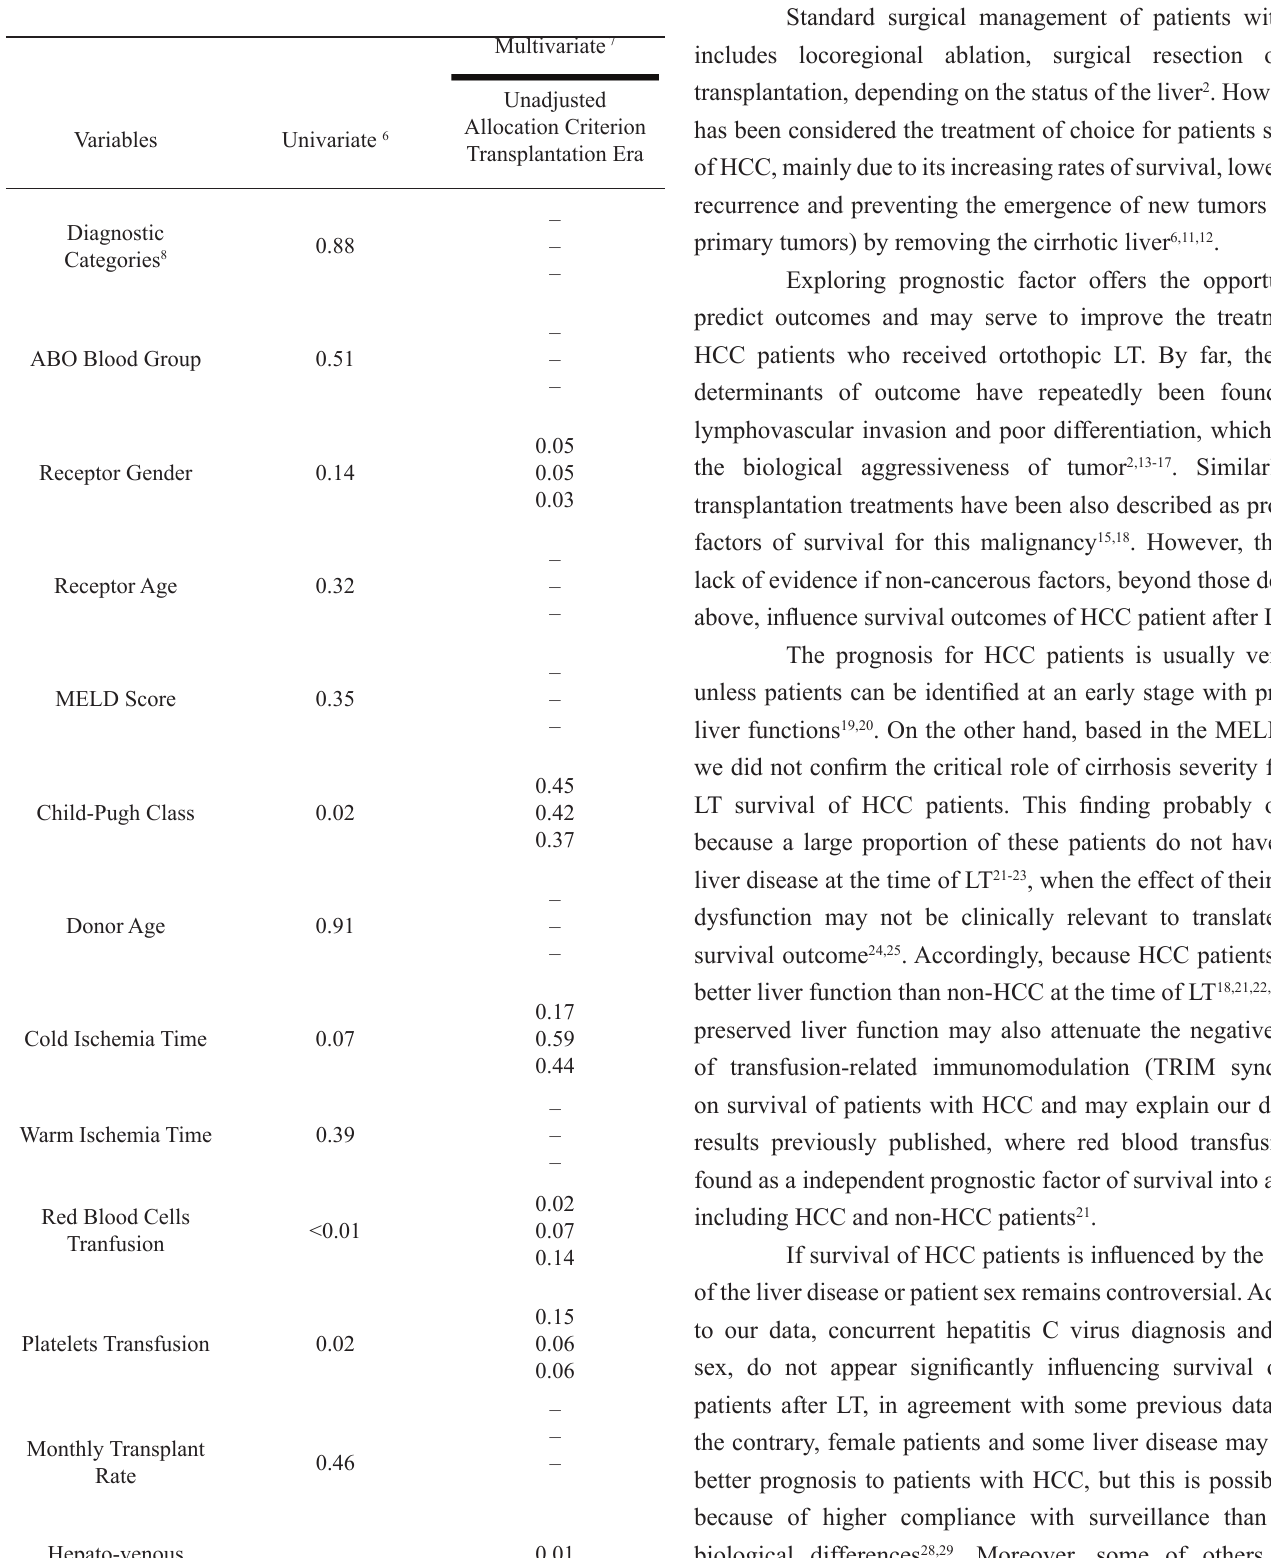
TABLE 2 - Non-cancerous prognostic factors (24-months survival) of hepatocellular carcinoma after liver